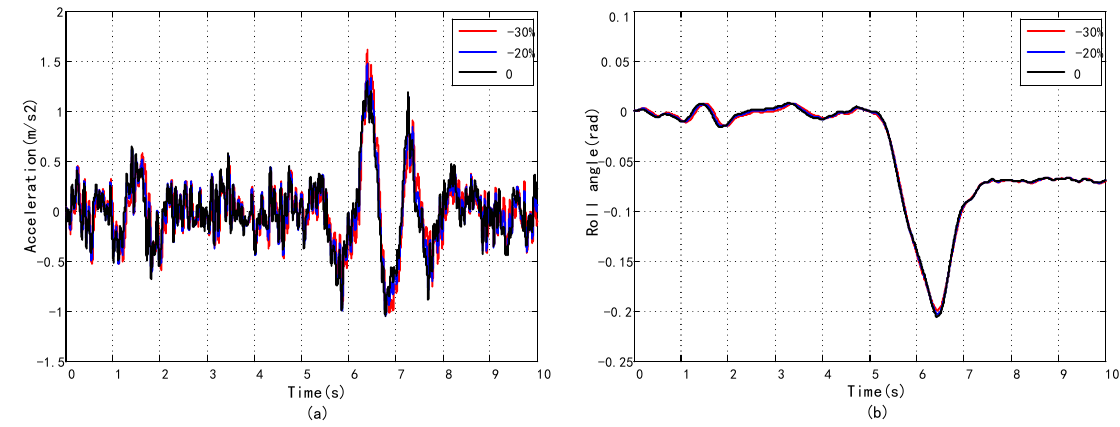
Figure 19. The robustness simulation curves with the uncertainty of vehicle speed: ( a ) the vehicle body vertical acceleration in time domain; ( b ) the roll angle acceleration in time domain.